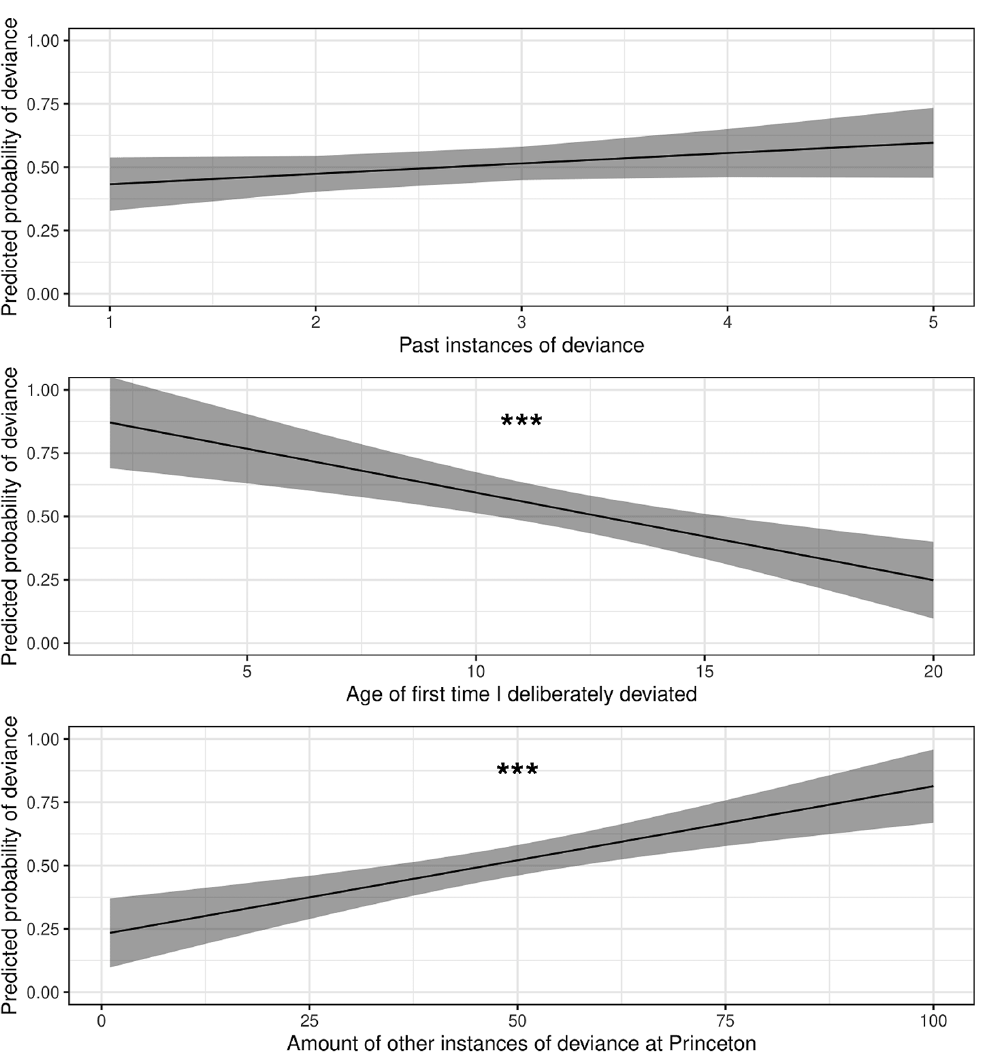
Figure 4. Predicted probability of deviance from the eating club norm, based on separate regressions of the binary eating club deviance item on self-reported deviance from other norms in the past and present, controlling for demographic variables set at their